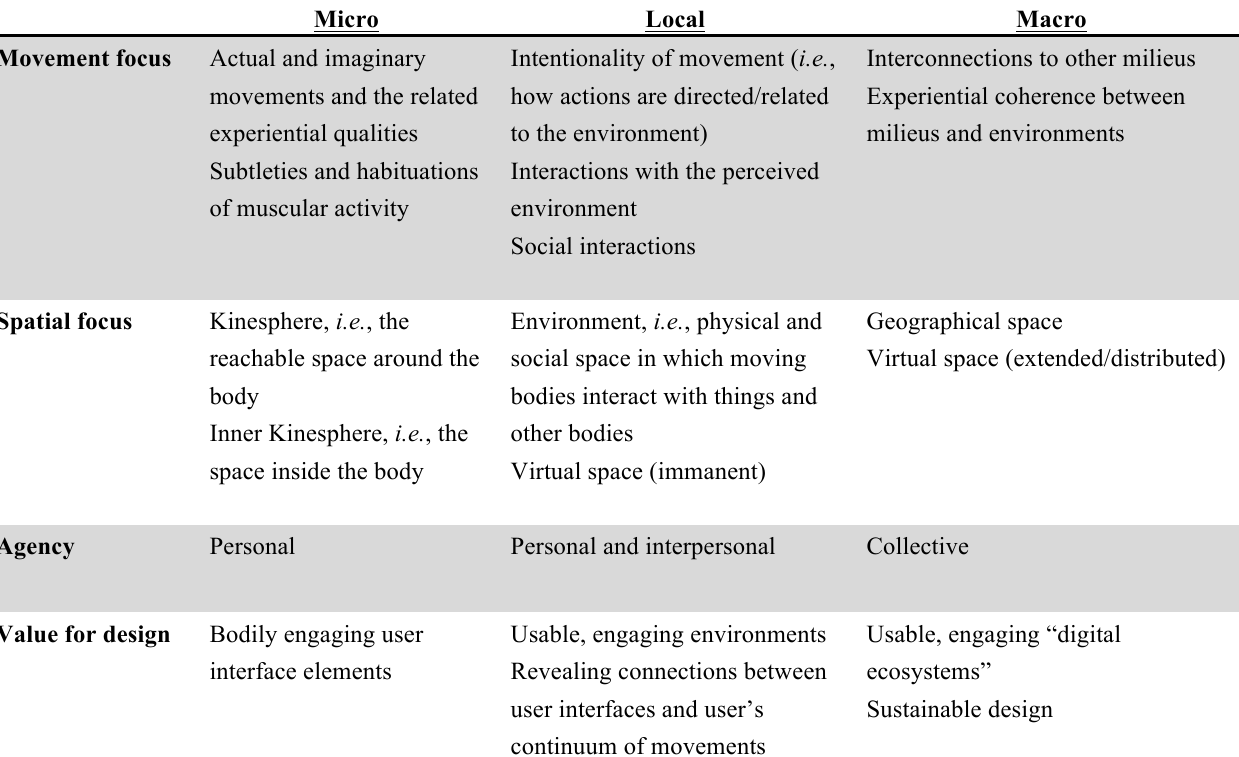
Table 1. A summary of the proposed levels of examination. Micro